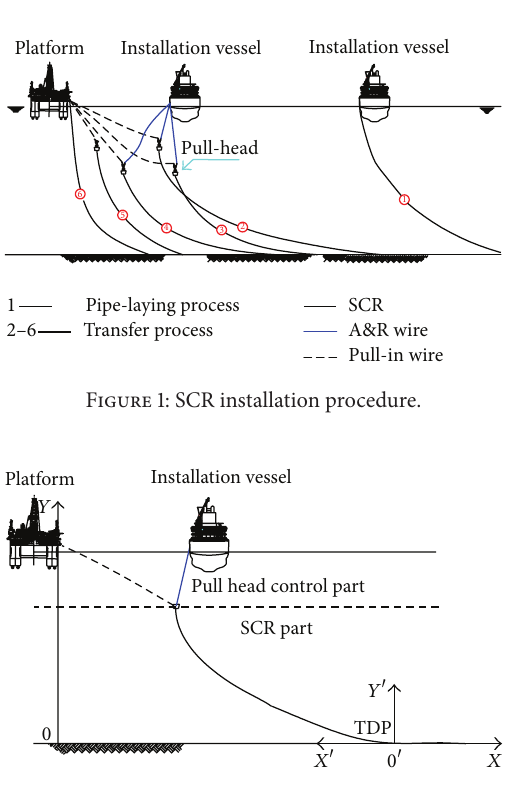
Figure2:MechanicalmodelfortransferprocessofSCRinstallation.